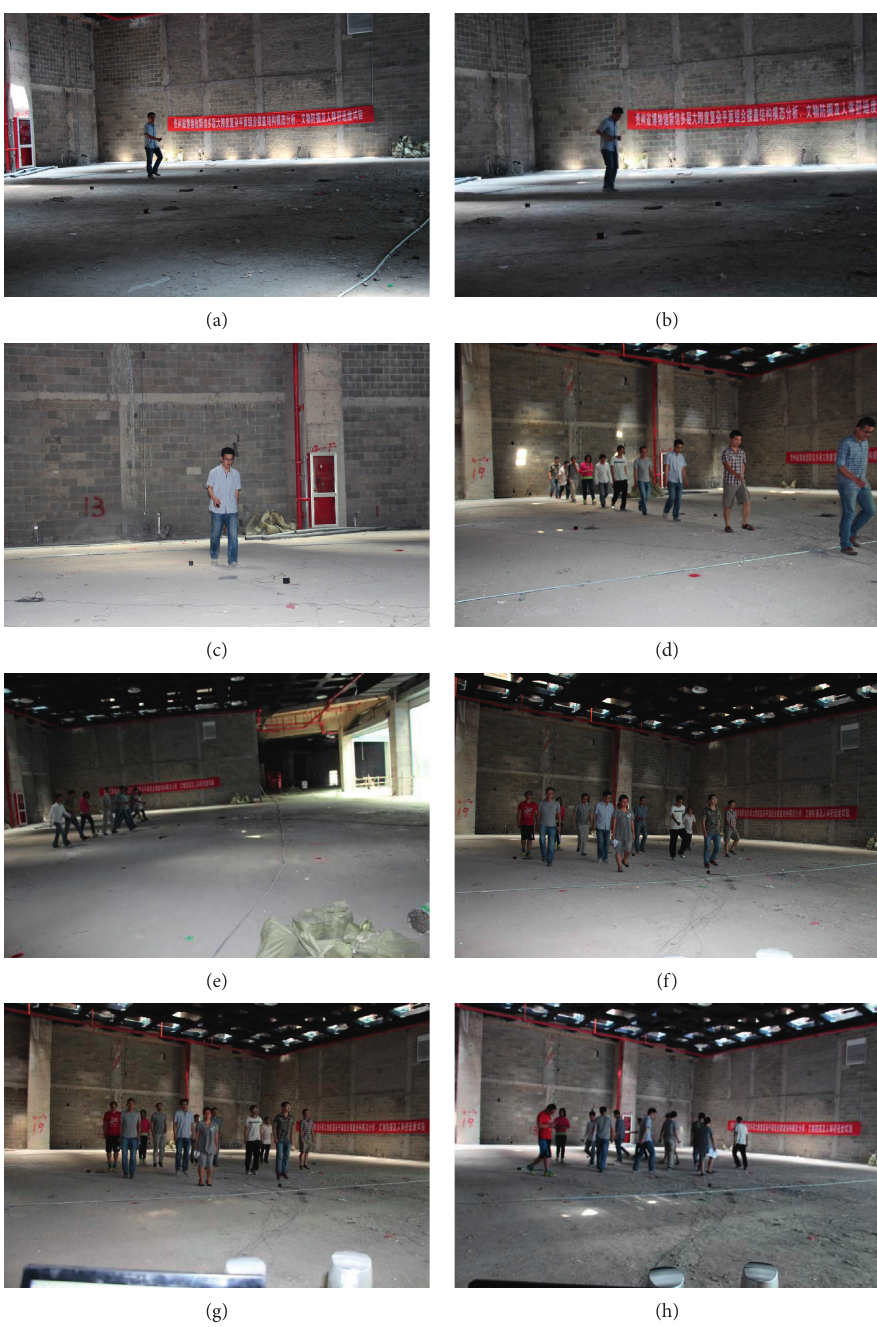
Figure 9: Experimental test: (a) solo experimenter stepping; (b) solo experimenter jumping; (c) solo experimenter walking along a designated route; (d) 10 experimenters in a line walking along a designated route; (e) 10 experimenters in a row walking along a designated route; (f) 12 experimenters stepping; (g) 12 experimenters jumping; (h) 12 experimenters walking in a designated